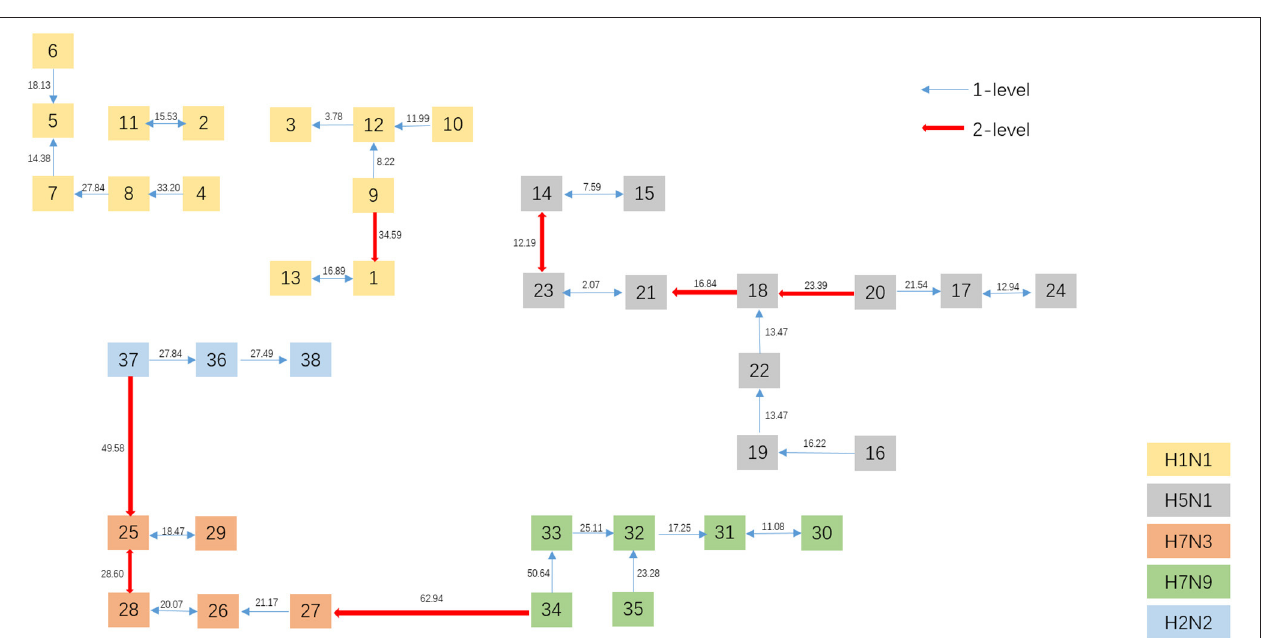
Hoang et al., 2015). The other two viruses are two new members in Coronavirus. Details of the Coronaviruses can be found in Table S1 . The new ChinaGD01 (Lu et al., 2015) was identified in